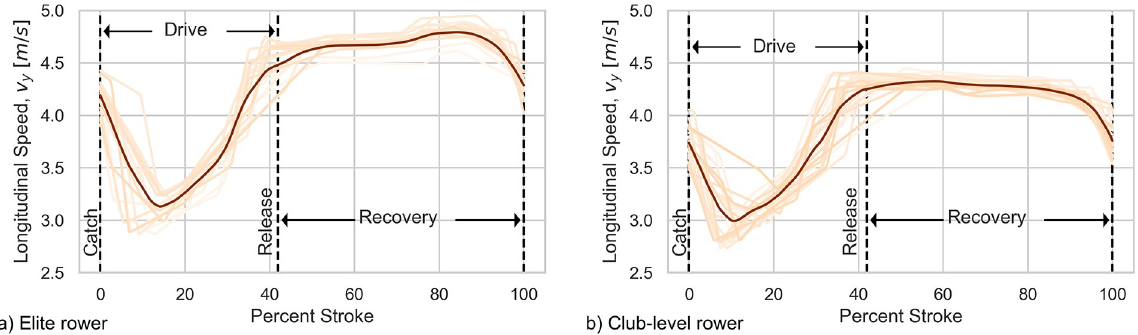
Fig 4. DGPS computed boat speed as a function of percent stroke for two trials (elite and club-level 24SE). Each stroke is plotted as an orange line and the mean of all strokes as a dark line. Because the DGPS data is sampled at only 5 Hz and the relative precision is lower than the accelerometer, the measured speed profile is less smooth and repeatable than the acceleration profiles in Fig